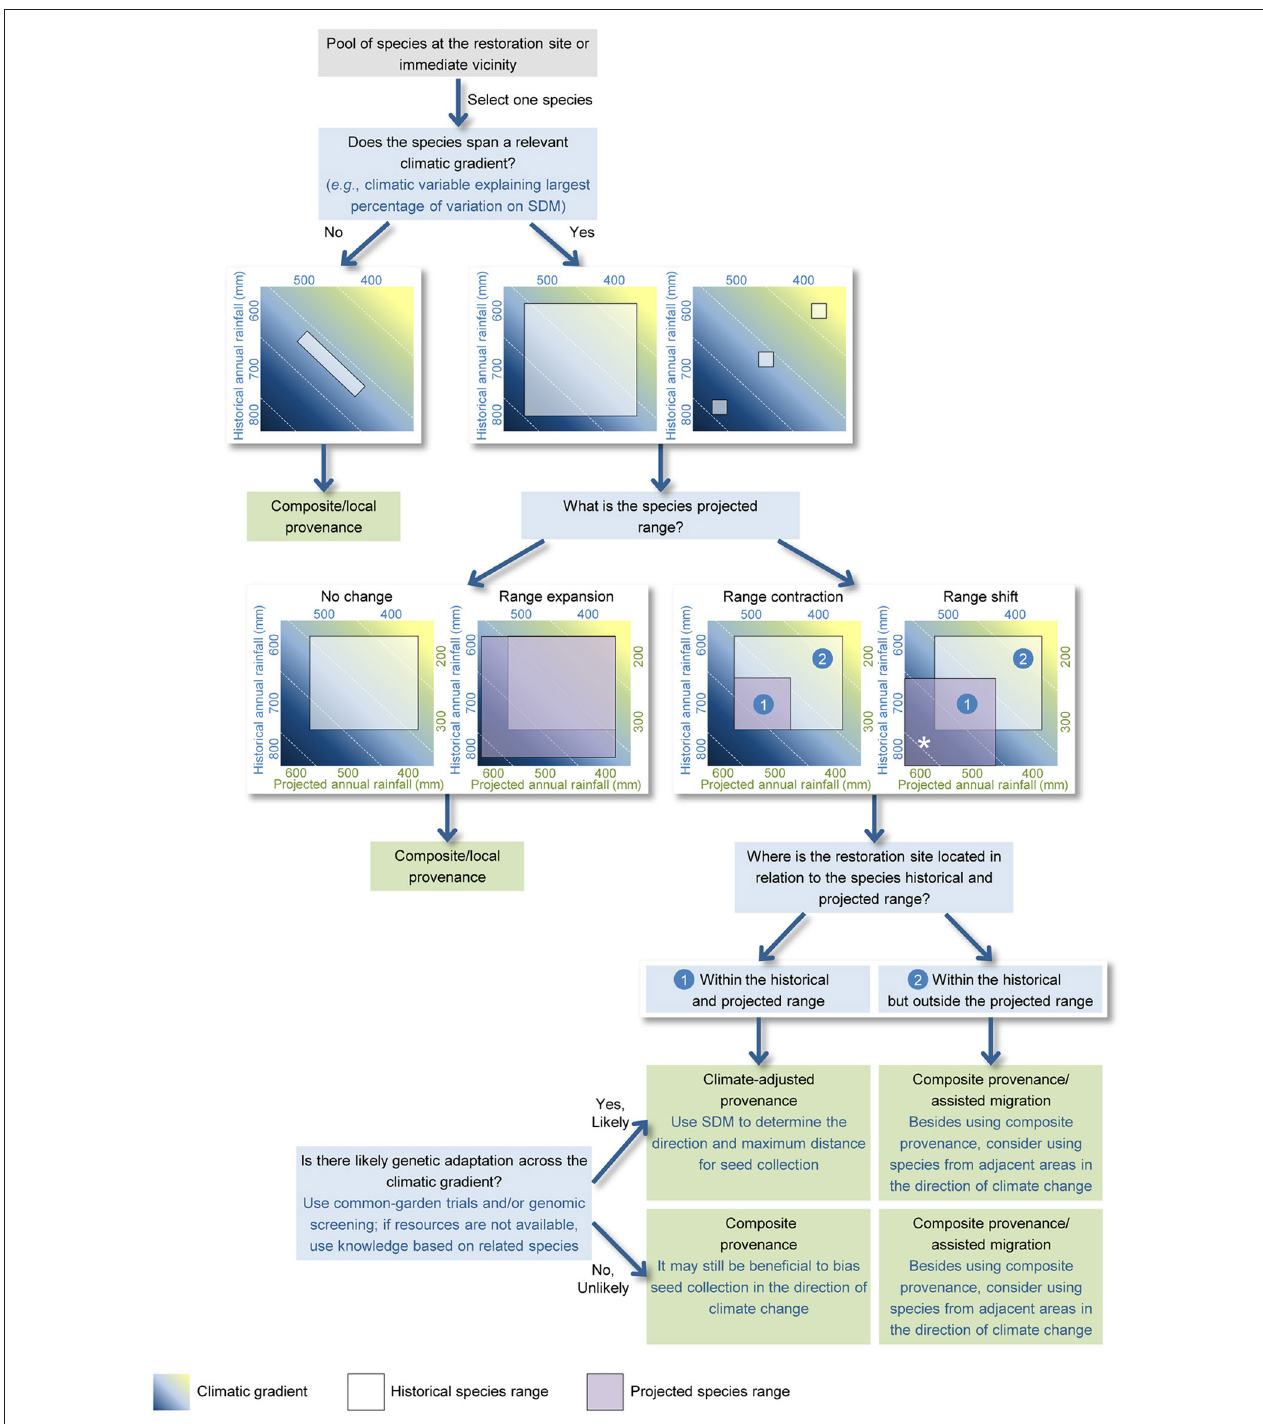
FIGURE 1 | A spatially explicit approach to support the decision-making process for seed provenance selection in ecological restoration when clear guidelines for genetic-based seed transfer are not available. The approach relies on the sequential query of spatial data (including species distribution, and historical and projected climatic conditions) to determine which provenance approach is likely most suitable for a given species at a given restoration site. Three main questions used are: (1) Does the species span a relevant climatic gradient? (2) What is the species projected range under future climate conditions? (3) Where is the restoration site located in relation to the species historical and projected range? The proposed approach can also help understanding which species from adjacent warmer and drier/wetter areas can be suitable for the revegetation works. In such cases, non-local species that are predicted to have their range shifted toward the restoration site (marked with an asterisk *) could be potential